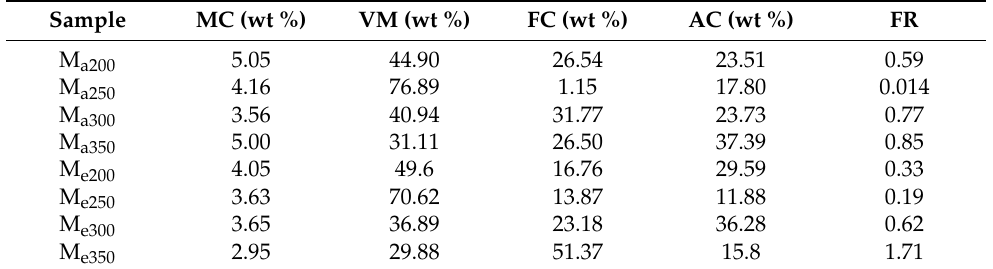
Table 1. Proximate analysis of the blended ratio of torrefied sewage sludge (SS) and raw bagasse